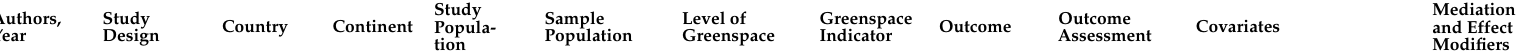
Table 1. Main characteristics of the